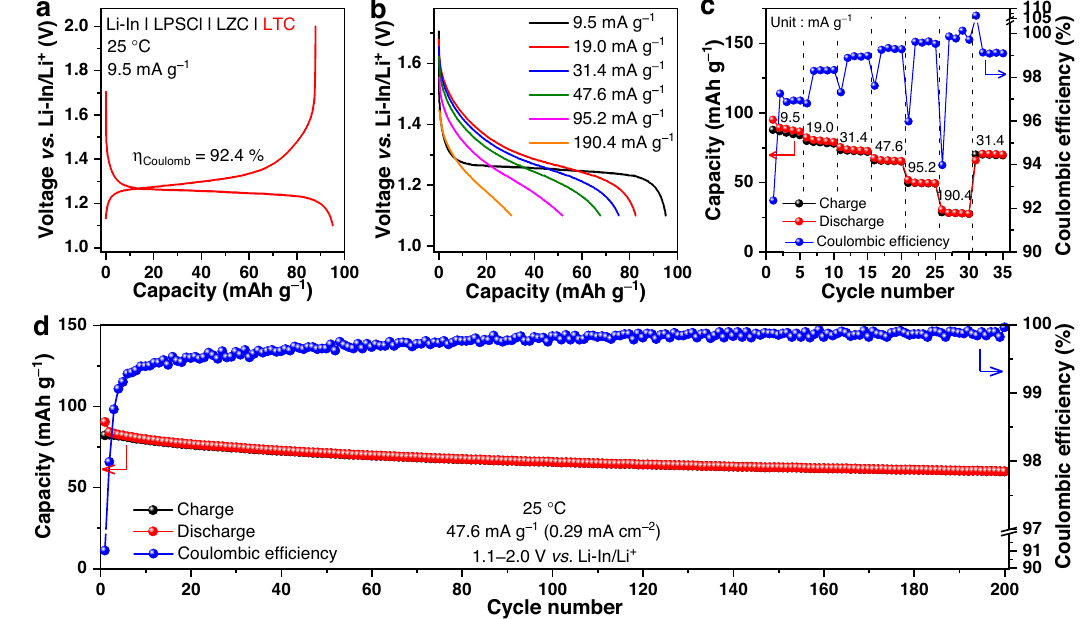
fl ecttheef fi ciencyofcycling. η Coulomb wouldstillbesmallerthanone,andthuscanre b , c Ratecapabilityat9.5,19.0,31.4,47.6,95.2,and190.4mAg − 1 at25°C. d Long-term cycling performance under 47.6mAg − 1 at 25°C. All the cells were operated at 1.1 − 2.0V vs. Li-In/Li +